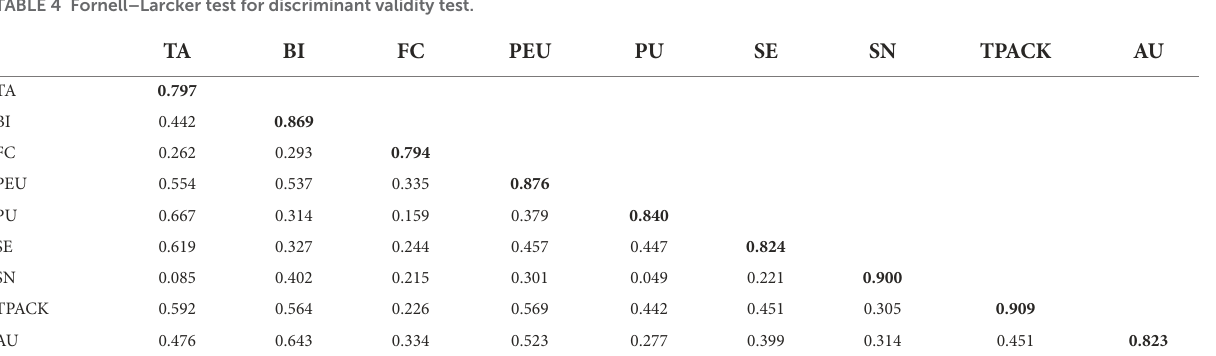
TABLE 4 Fornell–Larcker test for discriminant validity test.